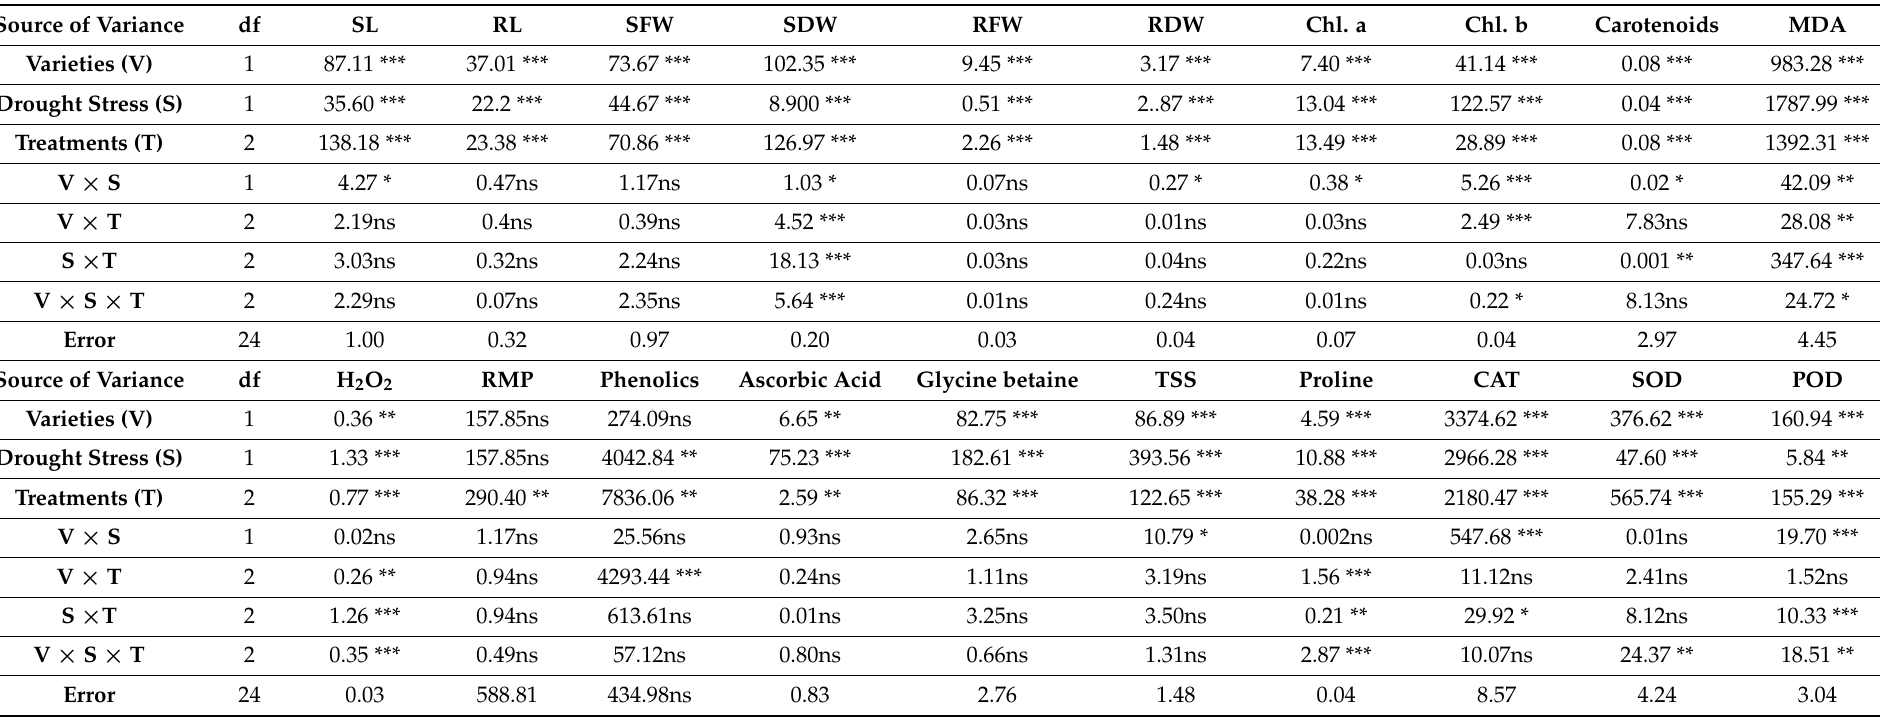
Table 1. Mean square values from analysis of variance (ANOVA) of data for foliar-applied salicylic acid with respect to growth, photosynthetic pigments and oxidative defense systems and osmolytes in wheat ( Triticum aestivum L.) grown under water-stress